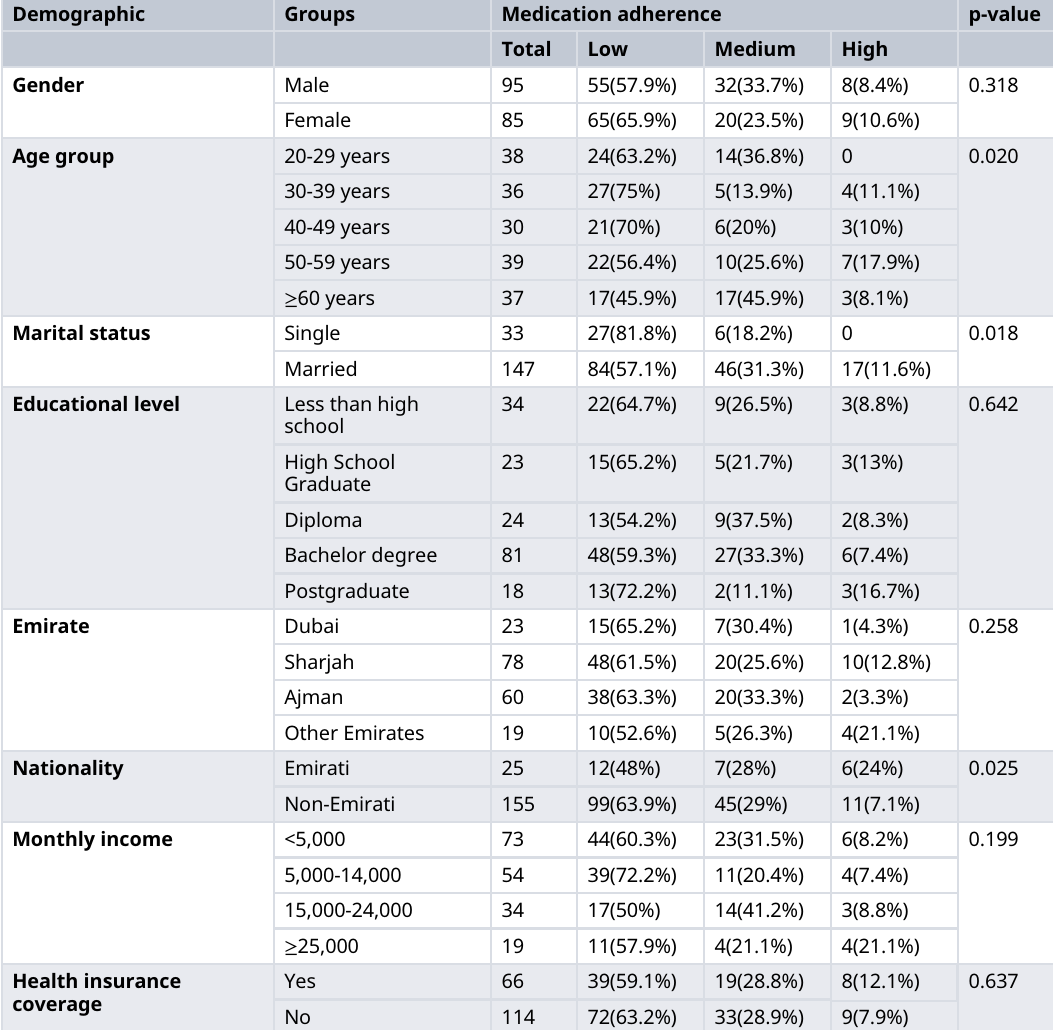
Table 4. Medication adherence according to demographic